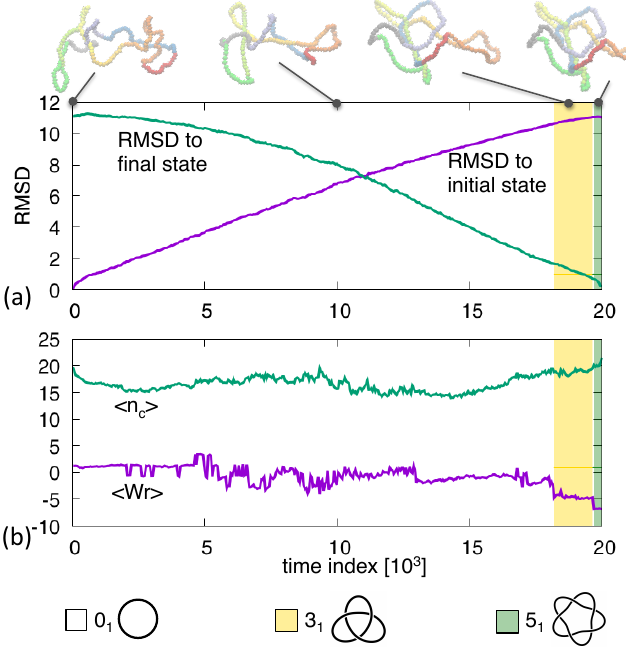
Figure 1. Transition pathway between an unknotted ring and a left-handed 5 1 knotted ring. The root-mean-square distance (RMSD) to the initial and final structures at various stages of the trajectory are shown in panel ( a ). Instantaneous configurations at selected times are highlighted. The average crossing number and writhe are shown in panel ( b ). The overlayed colored background indicates the non-trivial topological states, see